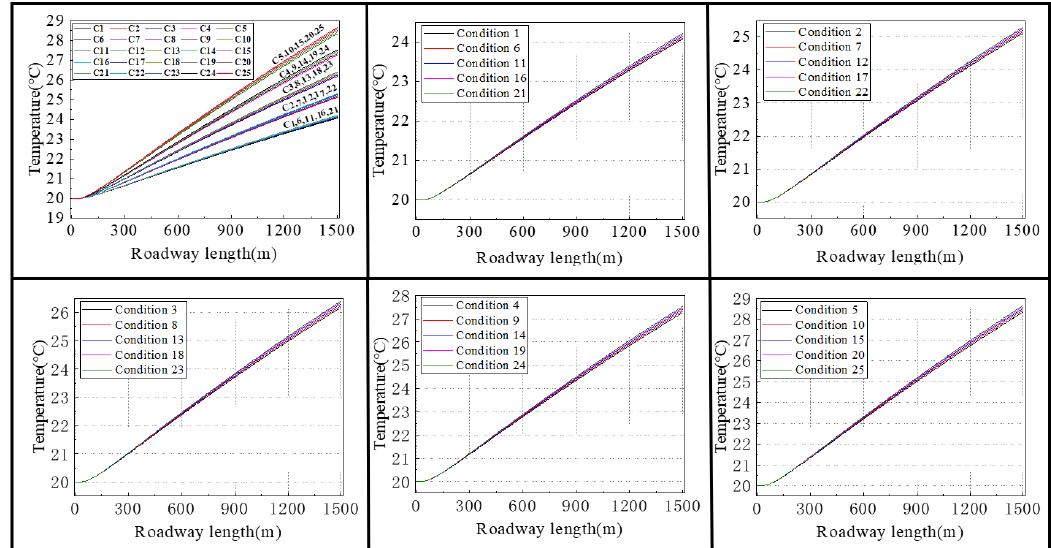
Figure 13. Airflow temperatures at various locations in the roadway at steady state for different upwelling water temperatures and the same upwelling water pressure.